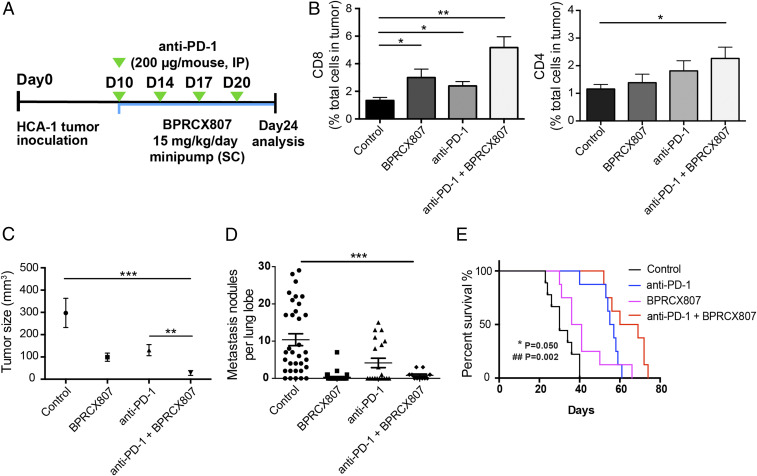
Synergistic effects of BPRCX807 with immune therapy in the orthotopic HCA-1 model. (A) Treatment protocol. Ten days after implantation of HCC cells, mice were treated with BPRCX807 (15 mg⋅kg−1⋅d−1, SC) by minipump from day 10 to day 24. Anti–PD-1 Ab (200 μg/mouse) was injected IP on days 10, 14, 17, and 20 after tumor implantation. (B) T cells (n = 6 to 13) shown in CD8+ T cells and CD4+ T cells. (C) Tumor sizes (n = 10 mice for control and BPRCX807; n = 8 mice for anti–PD-1 and anti–PD-1 + BPRCX807). (D) Counts of lung nodules (n = 11 to 34). (E) Overall survival (n = 8). *P = 0.050, anti–PD-1 plus BPRCX807 vs. anti–PD-1 alone; ##P = 0.002, anti–PD-1 plus BPRCX807 vs. BPRCX807 alone. The data are the mean value ± SEM. *P < 0.05, **P < 0.01, and ***P < 0.001.